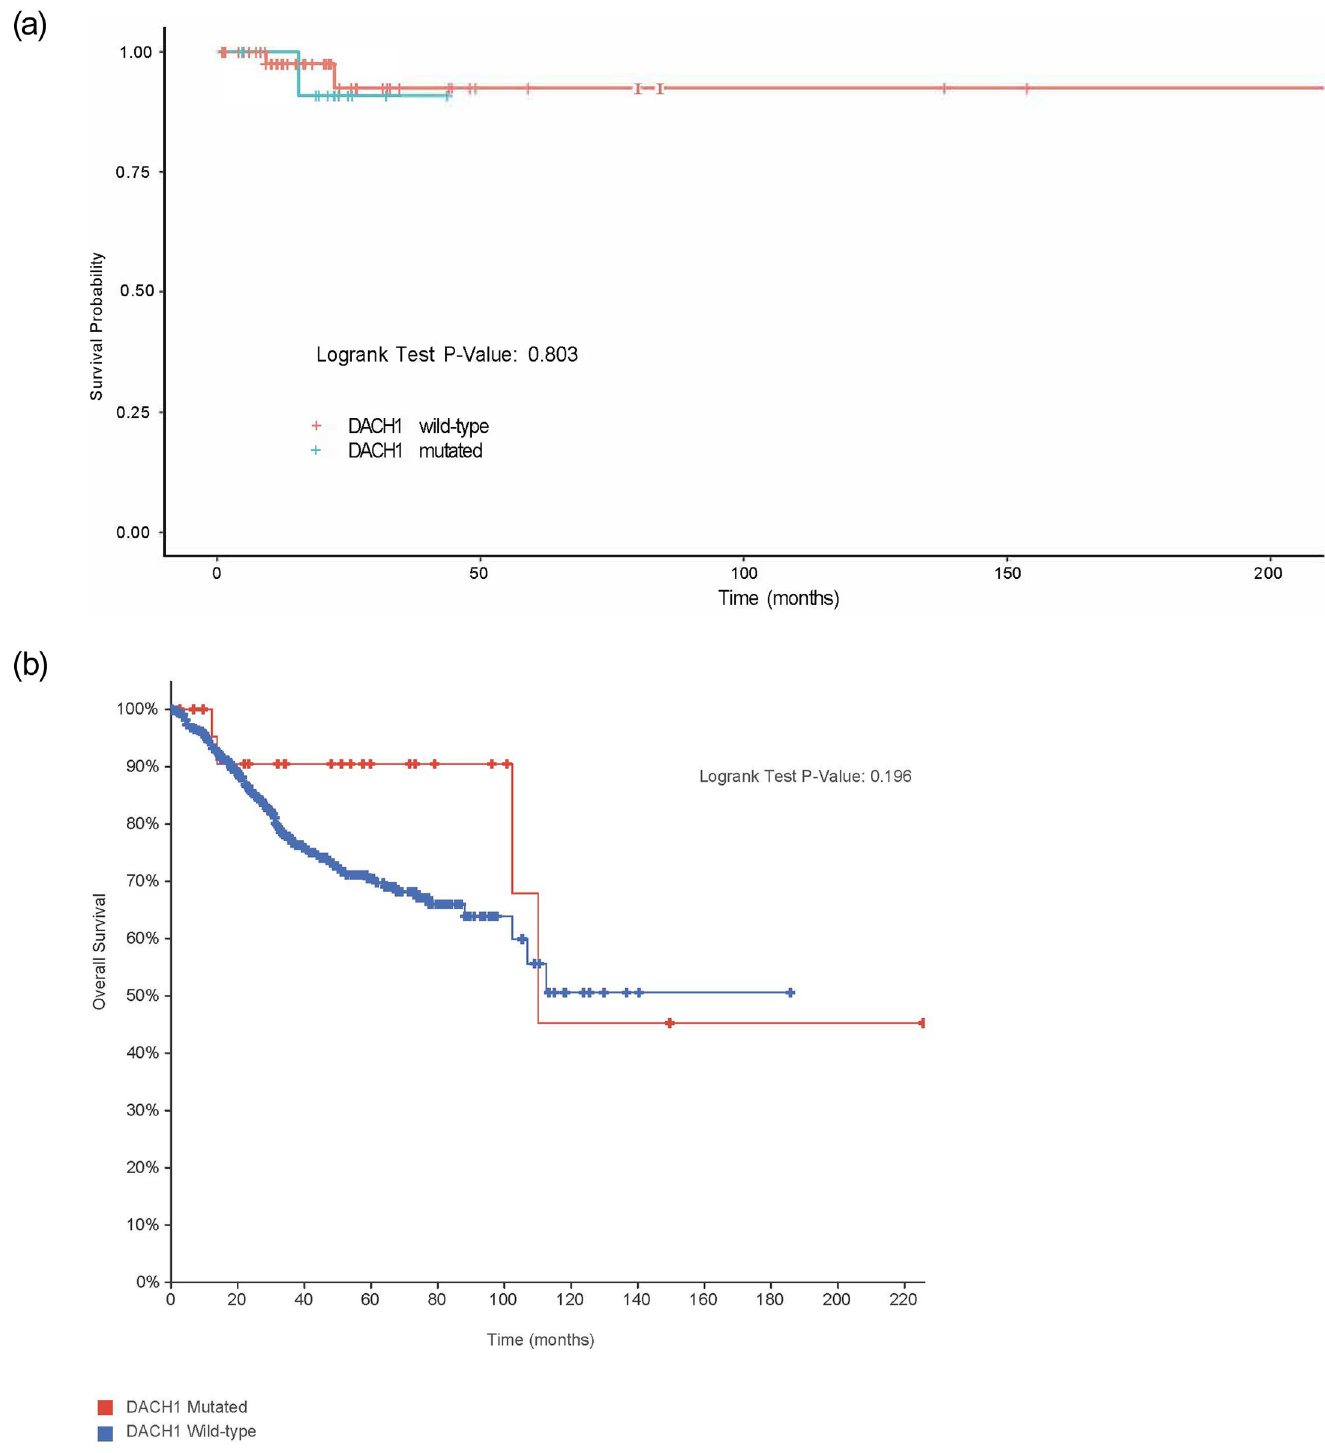
Fig 8. Overall survival (months) between DACH1 mutated patients versus wild-type. (A). Overall survival (months) between DACH1 mutated patients and wild- type at MCC, corrected for stage and grade, were found to be similar withno significant difference (p-value = 0.803) though limited outcome data in DACH1 mutated patients. (B). Overall survival (months) between DACH1 mutated patients and wild-type was also evaluated in the TCGA PCA (p-value = 0.196) patients with no significant difference.